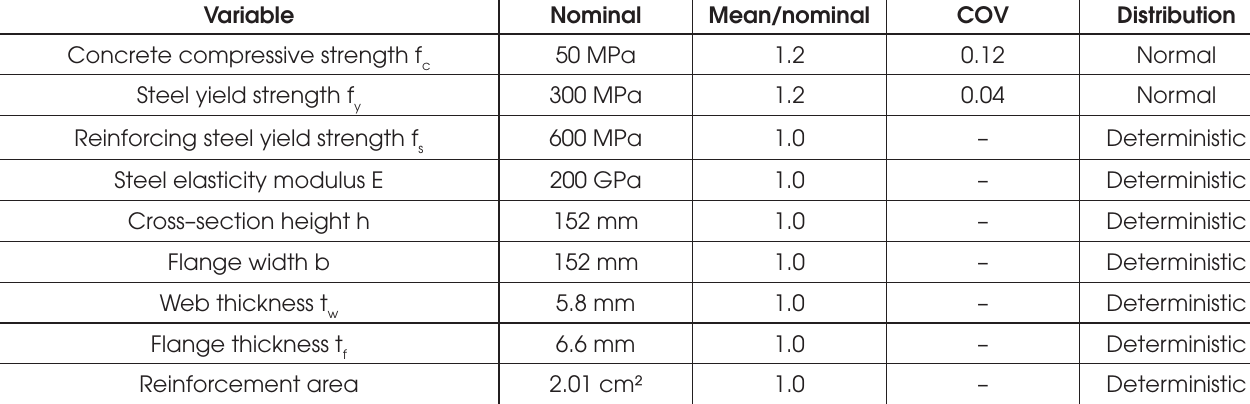
Cross-section characteristics of studied column